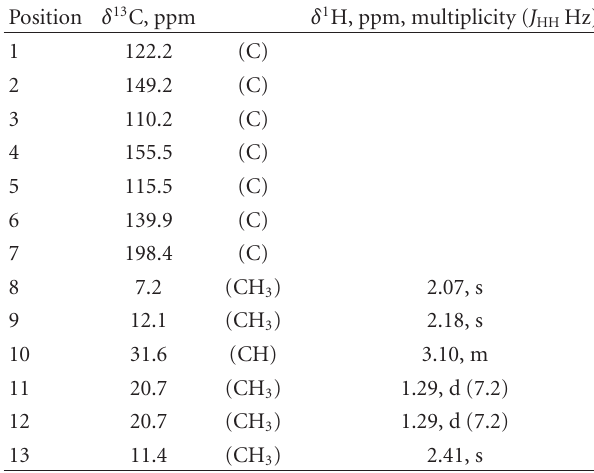
Table 1: NMR data of 1